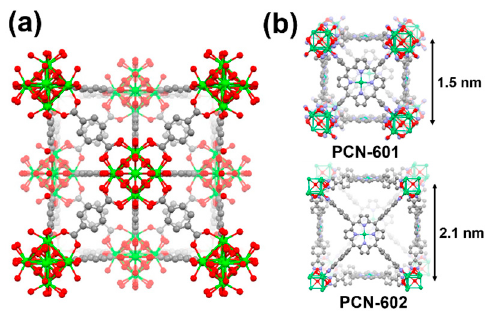
Figure 4. Crystal structures of ( a ) UiO-66 [28] and ( b ) PCN-601 and PCN-602 [78,79]. Lime green: Zr; red: O; grey: C; malachite: Ni; light slate blue: N. Hydrogen atoms are not shown for clarity.